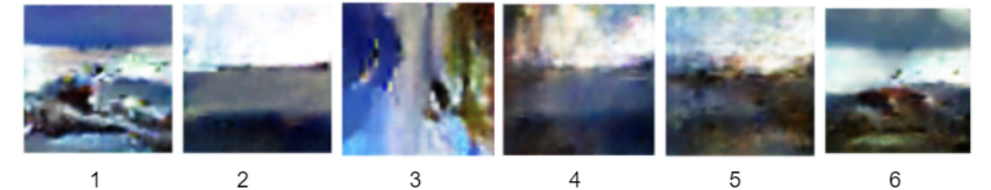
Figure 31. Trained Generator Output.